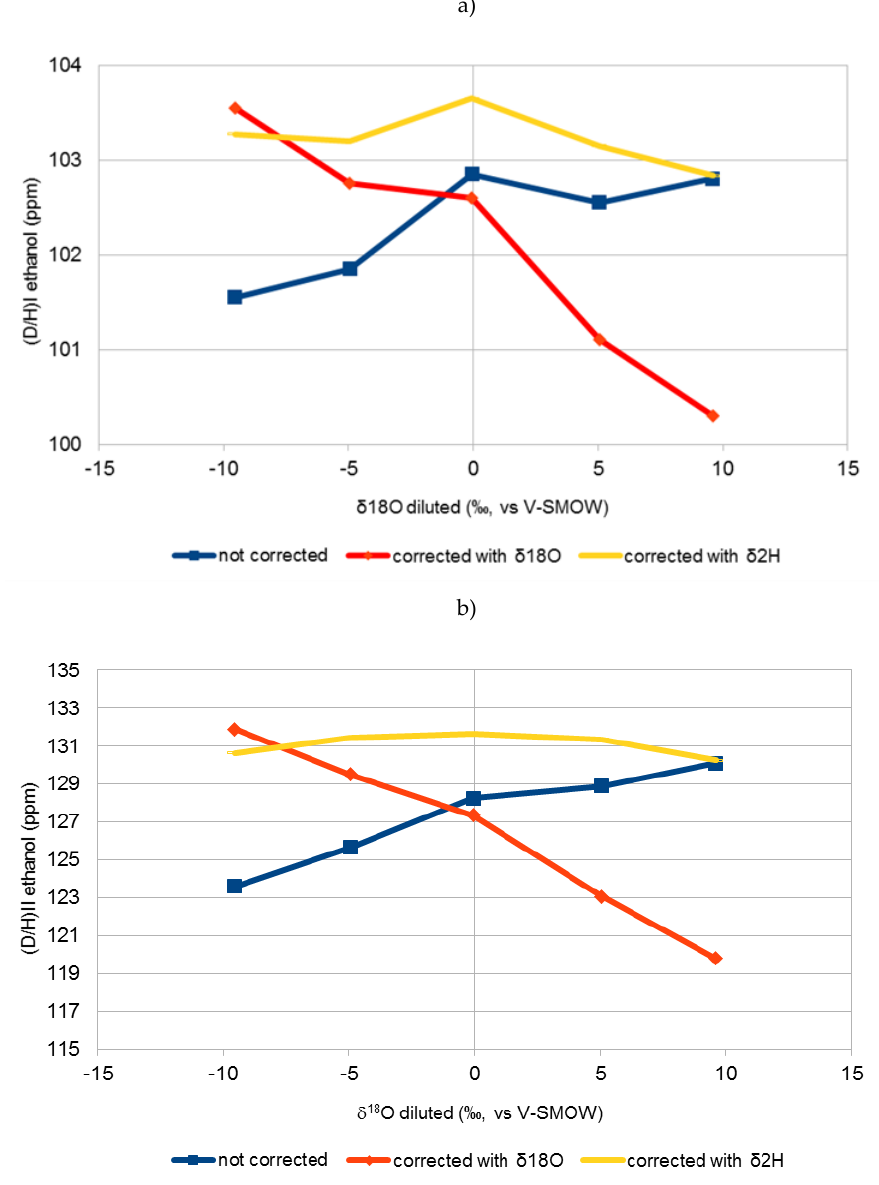
Figure 3. Variation of uncorrected (D / H) I ( a ) and (D / H) II ( b ) values of ethanol vs. δ 18 O of water of diluted grape sugar samples (red line) and e ff ect of the correction on the (D / H) I and (D / H) II of ethanol (Equations (1) and (2)) using δ 18 O (Equation (5)) (blue line) and δ 2 H (Equation (6)) (yellow line), values reported in Table 1 of the diluted sugar samples. Each point is the mean of two samples.